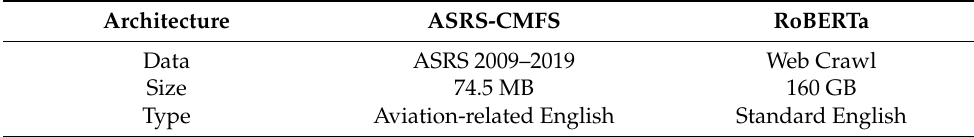
Table 8. Comparison of amount of textual data used for